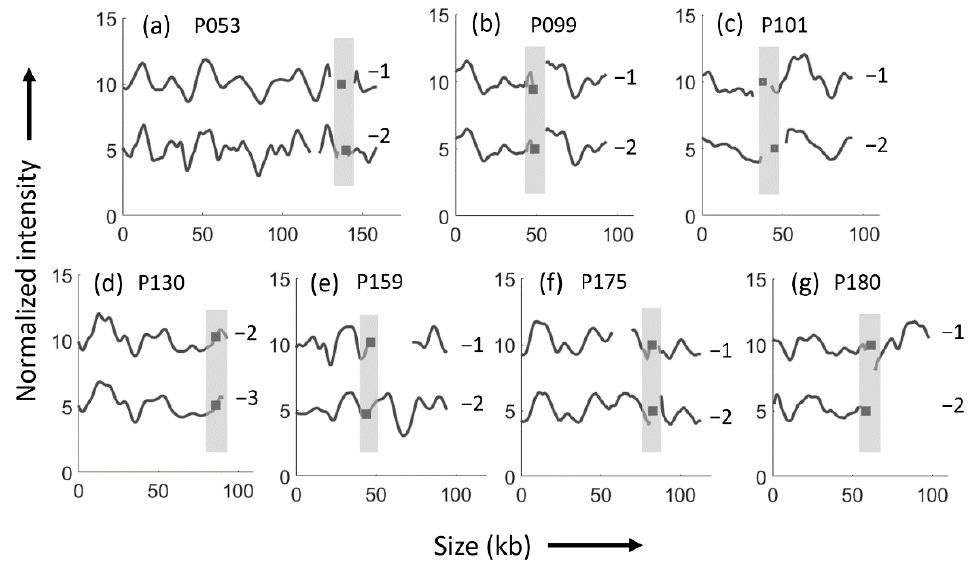
Figure 2. ODM results of ESBL E. coli isolates analyzed for bla CTX-M gene in seven patients with consecutive episodes of recurrent urinary tract infections caused by the same ESBL E. coli strains. ODM barcodes for ( a ) patient P053, with ~150 kb plasmid carrying the bla CTX-M-15 gene at the same location in both isolates; ( b ) patient P099, with identical 93 kb plasmids carrying the bla CTX-M-14 gene at the same location in both isolates; ( c ) patient P101, with ~90 kb plasmids carrying the bla CTX-M-15 gene at the same location in both isolates; ( d ) patient P130 (isolates P130-2 and P130-3), with identical plasmids of 93 kb length carrying the bla CTX-M-15 at the same location in both isolates; ( e ) patient P159, with plasmids of different size (P159-1; 71 kb and P159-2; 95 kb) carrying bla CTX-M-3 gene at the same location in both isolates; ( f ) patient P175, with plasmids of different size (P175-1; 104 kb and P175-2; 113 kb) carrying the bla CTX-M-14 gene at the same location in both isolates; ( g ) patient P180, with plasmids of different size (P180-1; 98 kb and P180-2; 62 kb) carrying the bla CTX-M-15 gene at the same location in both isolates. Black squares indicate the location of the gene and the regions shaded in grey indicates that the gene is in the same location.